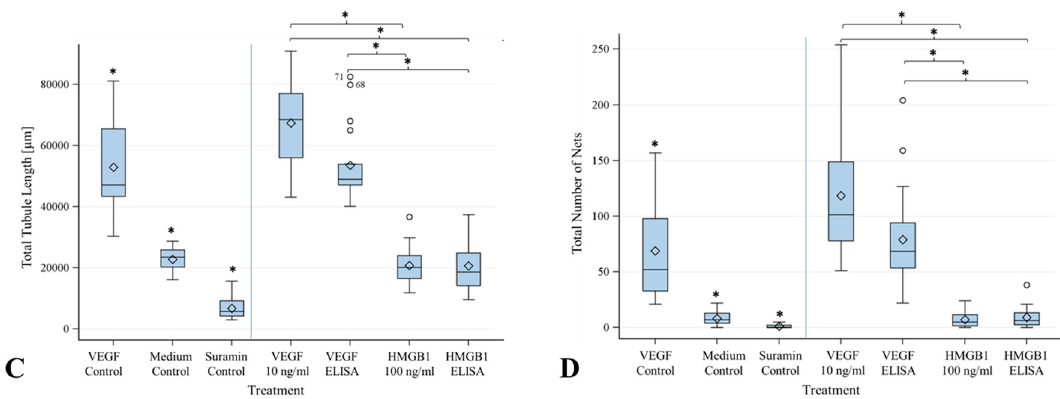
Figure 8. Results of Angiogenesis Assay with proangiogenic cytokines VEGF and HMGB1. Angiogenesis Assay with VEGF at a steady concentration of 10 ng/mL ( n = 4) and a declining concentration of 117 ng/mL on day 2, 16 ng/mL on day 5, 7 ng/mL on day 8 and 6 ng/mL on day 11 ( n = 4), respectively. HMGB1 was used at a steady concentration of 100 ng/mL ( n = 4) and a declining concentration of 924 ng/mL at day 2, 130 ng/mL at day 5, 76 ng/mL at day 8 and 24 ng/mL at day 11, respectively. Results for Total Number of Junctions ( A ); Total Number of Tubules ( B ); Total Tubule Length (µm) ( C ); and Total Number of Nets ( D ) were analyzed using F -test from the analysis of variance followed by pairwise multiple means comparisons with the use of the Least Significant Difference ( p ≤ 0.05). Both, VEGF using a concentration of 10 ng/mL and the declining concentrations, showed an angiogenesis stimulating effect. The steady concentration of 10 ng/mL showed significantly more tubules and junction formation than the declining concentrations. Neither the constant concentration of 100 ng/mL HMGB1 nor the declining concentrations of HMGB1 showed an angiogenesis stimulating effect.